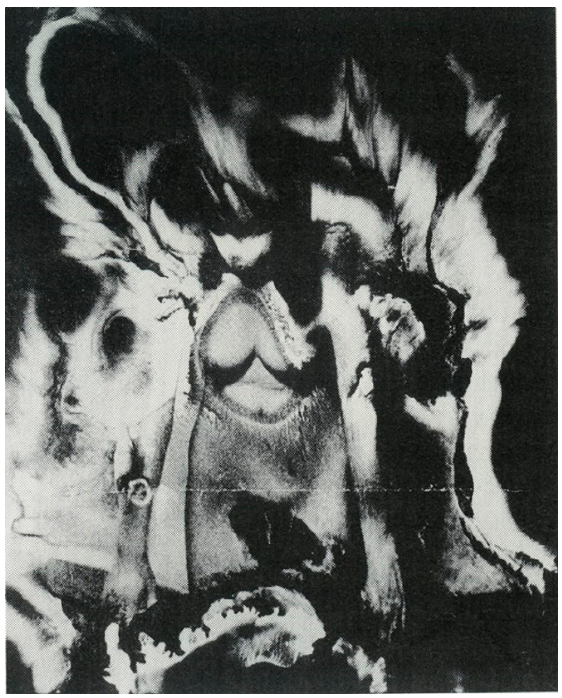
Figure 4. David Hare, Marine Fire , View , January 1942. In public domain.